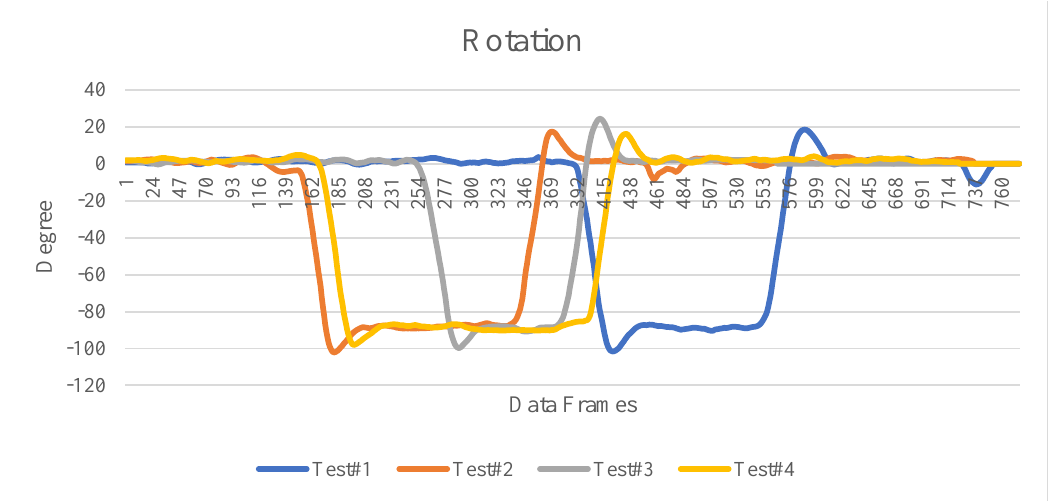
Figure 14. Active localization of IMR based on e-SLAM.